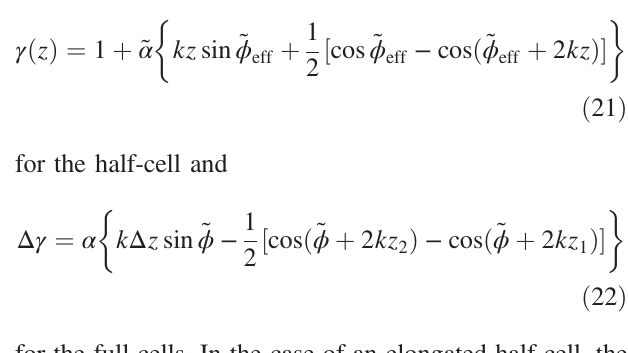
FIG. 7. Energy gain in an elongated half-cell versus start phase, α ¼ 1 . 8 ; ε ¼ 0 . 2 . The dashed line shows the analytical result ~ ϕ ¼ ϕ þ 1 − Δ ϕ el ], while the exact solution is [Eq. (21) with 0 2 α 2 eff shown as a solid